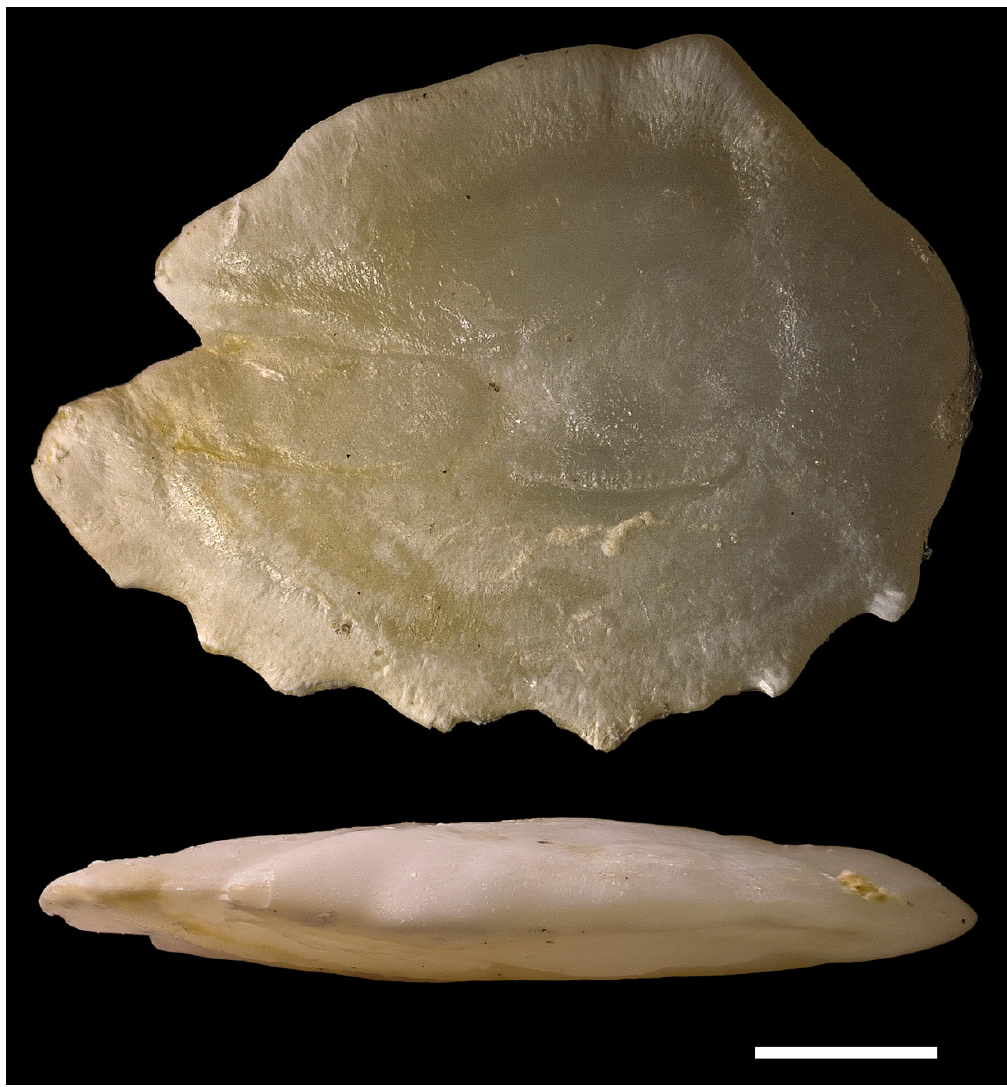
Figure 3. Diaphus balanovi sp. nov., right otolith (sagitta), inner face ( top ), and dorsal view ( bottom ). Scale bar: 1 mm.